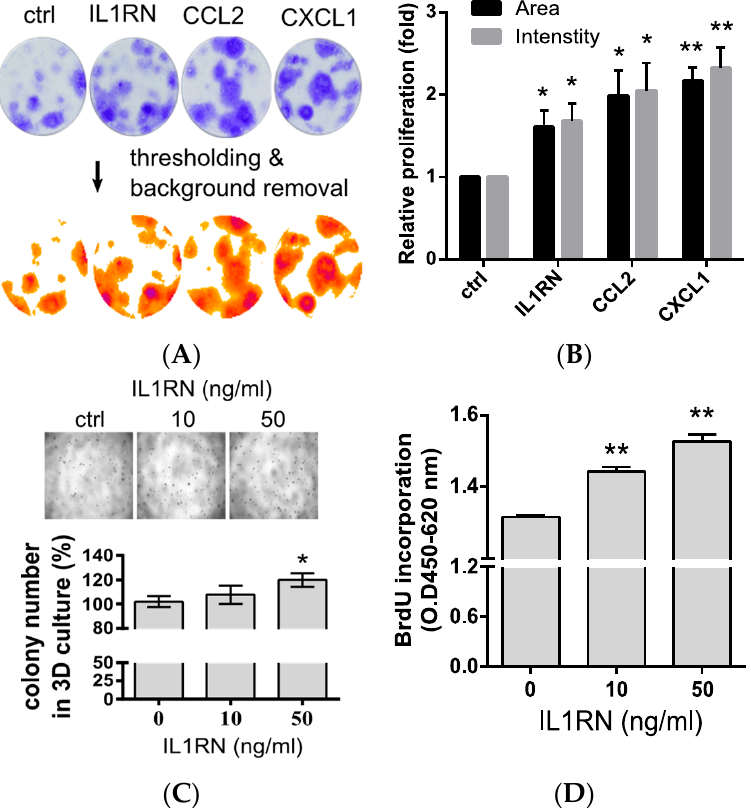
Figure 4. Proliferation effects of the interleukin (IL)-1 receptor antagonist (IL1RN) in transgenic adenocarcinoma of the mouse prostate (TRAMP)-C1 cells. ( A ) Colony assays using selected chemokines identified in cluster of differentiation 11b (CD11b)-negative (CD11b - ) cells collected from TRAMP-C1-derived tumors. TRAMP-C1 cell lines were incubated with an individual chemokine (50 ng/mL). Images were processed by Image J using the ColonyArea plug-in [17]. ( B ) Quantification of the colony occupied sizes (Areas) and staining signals (Intensities), from Panel (A); n = 3. ( C ) Monitoring of